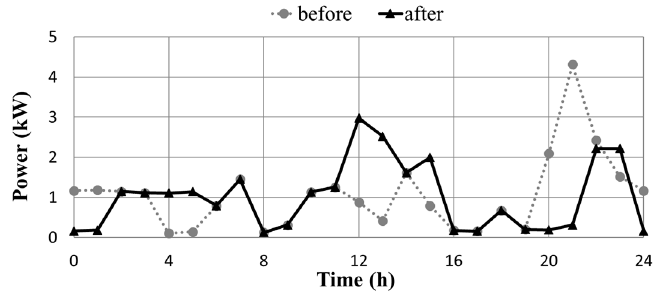
Figure 3. Load demand before and after the prosumer problem solution.